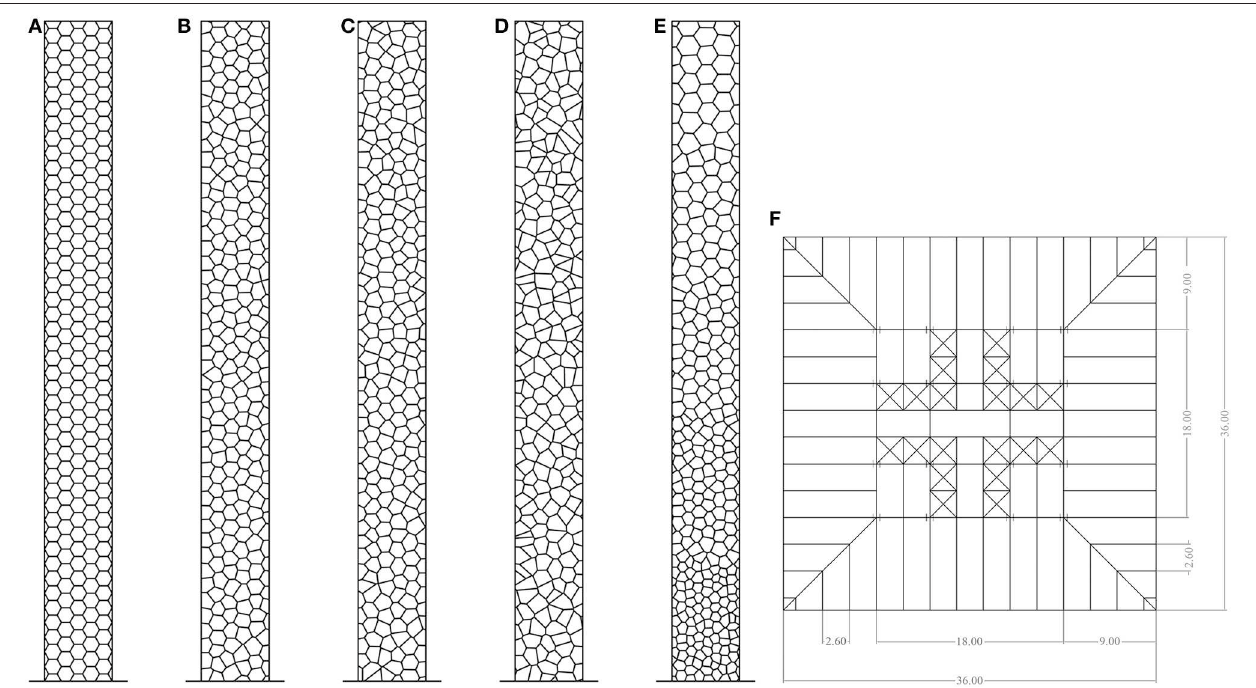
FIGURE 8 | Building model: (A) Regular hexagrid ( α with varying density ρ and (F) plan